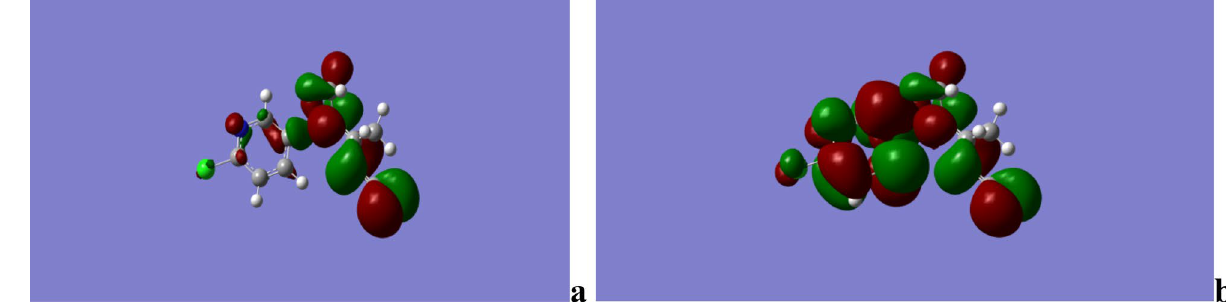
Figure 17. Acetamiorid HOMO ( a ) and LUMO ( b ).